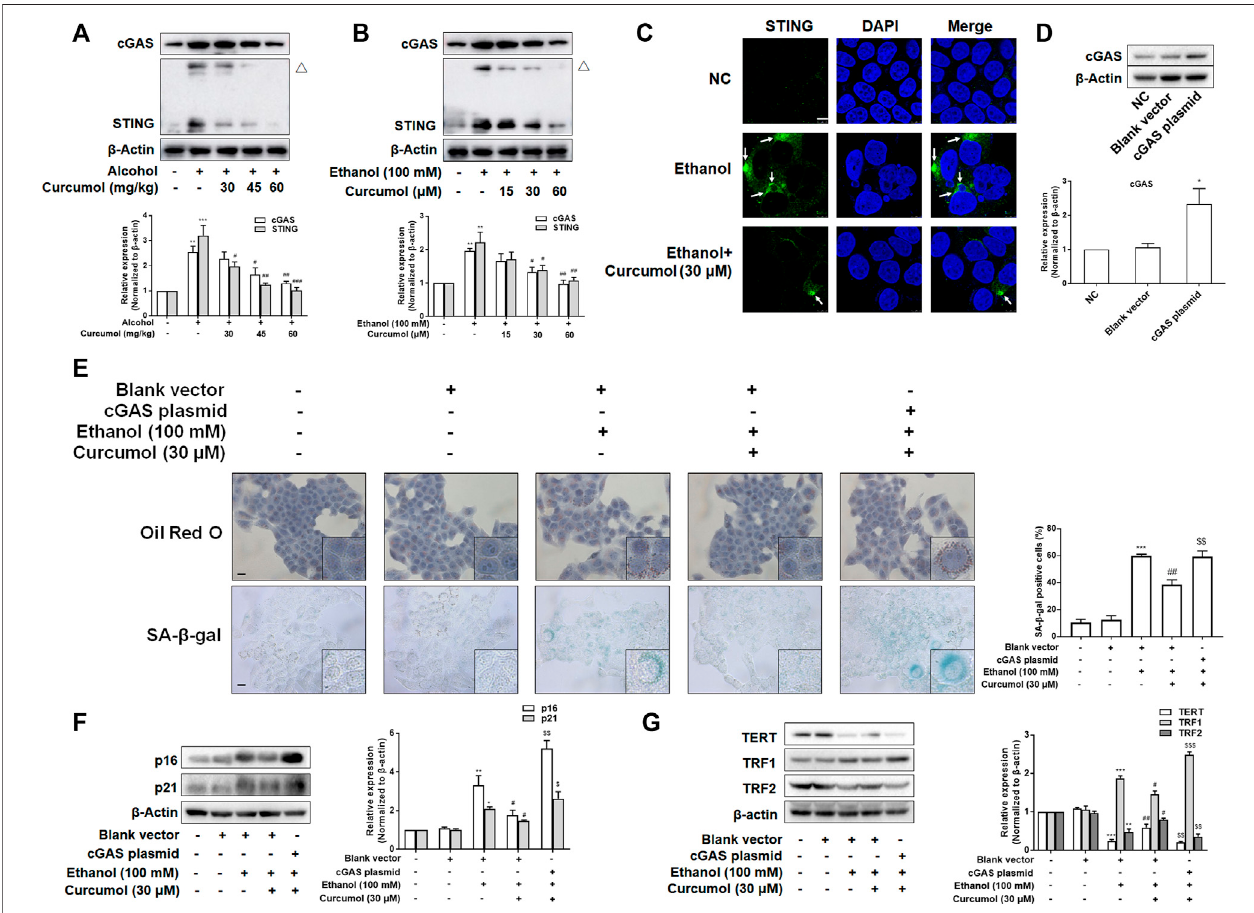
FIGURE 4 | The activation of cGAS-STING weakened the effect of curcumol on cellular senescence in ethanol-treated LO2 cells. (A) Western blot analyses of the expressions of cGAS and STING in vivo , n = 3. STING blots were performed under non-reducing conditions. △ STING dimer. Data are represented as mean ± SD. Signi fi cance: ** p < 0.01, and *** p < 0.001 versus control group, # p < 0.05, ## p < 0.01, and ### p < 0.001 versus alcohol group. (B) Western blot analyses of the expressionsofcGAS andSTING invitro , n =3.STING blotswereperformedundernon-reducingconditions. △ STINGdimer.Dataarerepresented asmean±SD. Signi fi cance:** p < 0.01versuscontrolgroup, # p < 0.05and ## p < 0.01versusethanolgroup. (C) ConfocalmicroscopyimagesofSTINGinLO2cells.Arrowsareusedto mark theredistribution ofSTING intoaggregates. Scare bar,7.5 μ m. (D) Westernblotanalyses thecGAS plasmidtransfection ef fi ciency, n =3. Dataarerepresentedas mean ± SD. Signi fi cance: *** p < 0.001 versus blank vector group. (E) Representative images of oil red O and SA- β -gal in LO2 cells, n = 3. Scale bar, 100 μ m data are represented as mean ± SD. Signi fi cance: *** p < 0.001 versus blank vector group, ## p < 0.01 versus blank vector + ethanol group, $$ p < 0.01 versus blank vector + ethanol + curcumol group. (F and G) Western blot analyses of protein expression of senescence markers (p16 and p21) and telomere and telomerase related factors (TERT, TRF1, and TRF2) protein levels in LO2 cells, n = 3. Data are represented as mean ± SD. Signi fi cance: * p < 0.05, ** p < 0.01, and *** p < 0.001 versus blank vector group, # p < 0.05 and ## p < 0.01 versus blank vector + ethanol group, $ p < 0.05, $$ p < 0.01, and $$$ p < 0.001 versus blank vector + ethanol + curcumol group.